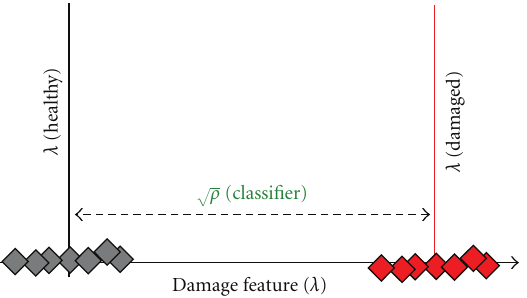
√ ρ Figure 4: represents the distance between mean value of λ for healthy performance and the mean value of λ for a damaged state.